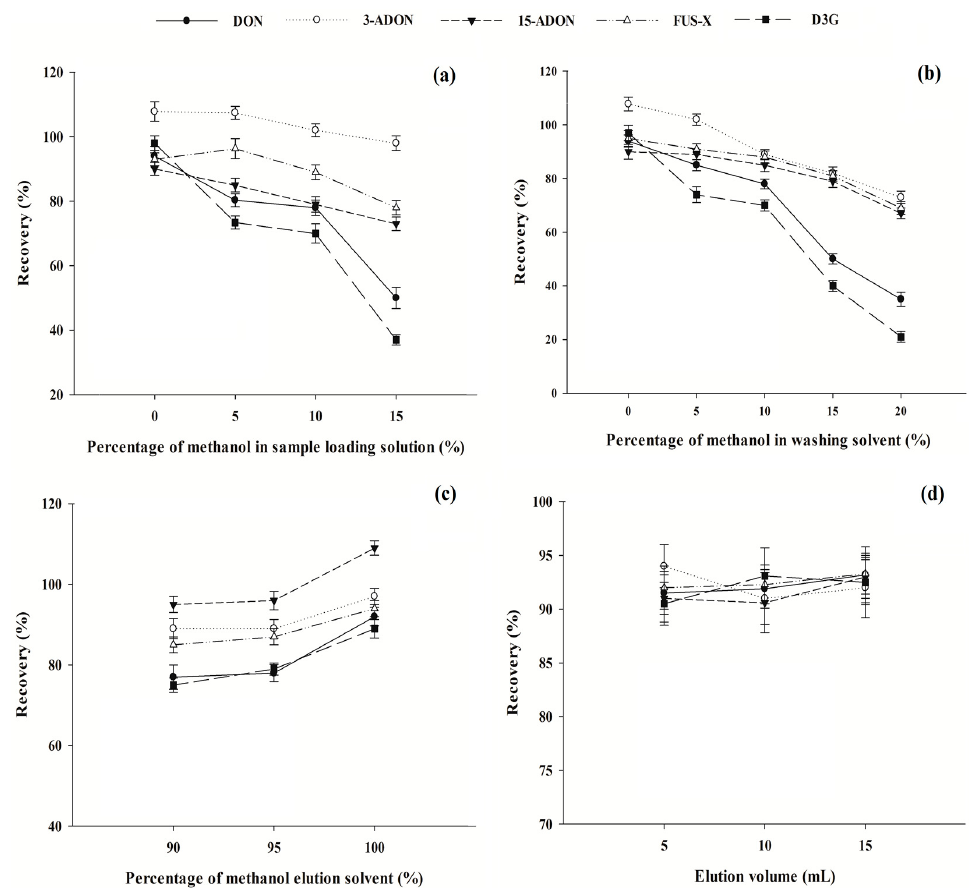
Figure 2. Effects of key parameters on the performance of HLB cartridges including the percentage of methanol in sample loading solution ( a ); the percentage of methanol in washing solvent ( b ); the percentage of methanol in elution solvent ( c ), and the elution volume ( d ). The concentrations of mycotoxins tested were 50 μ g/kg ( n = 3).